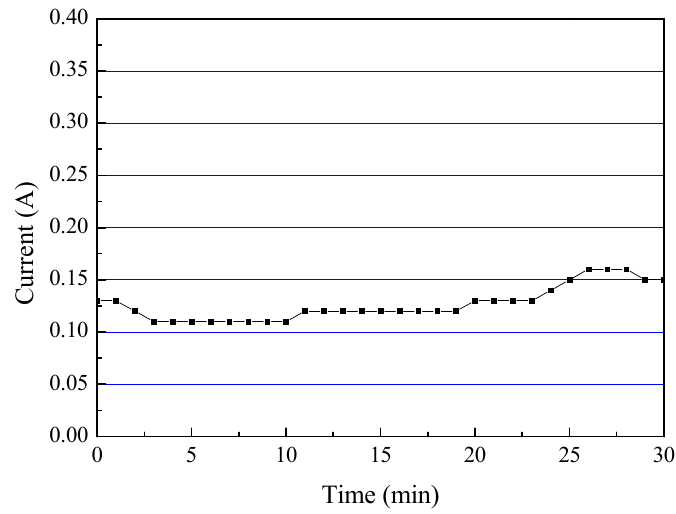
Figure 1. Current vs. time curve of modified alumina film in the experiment of copper nanowires deposition.